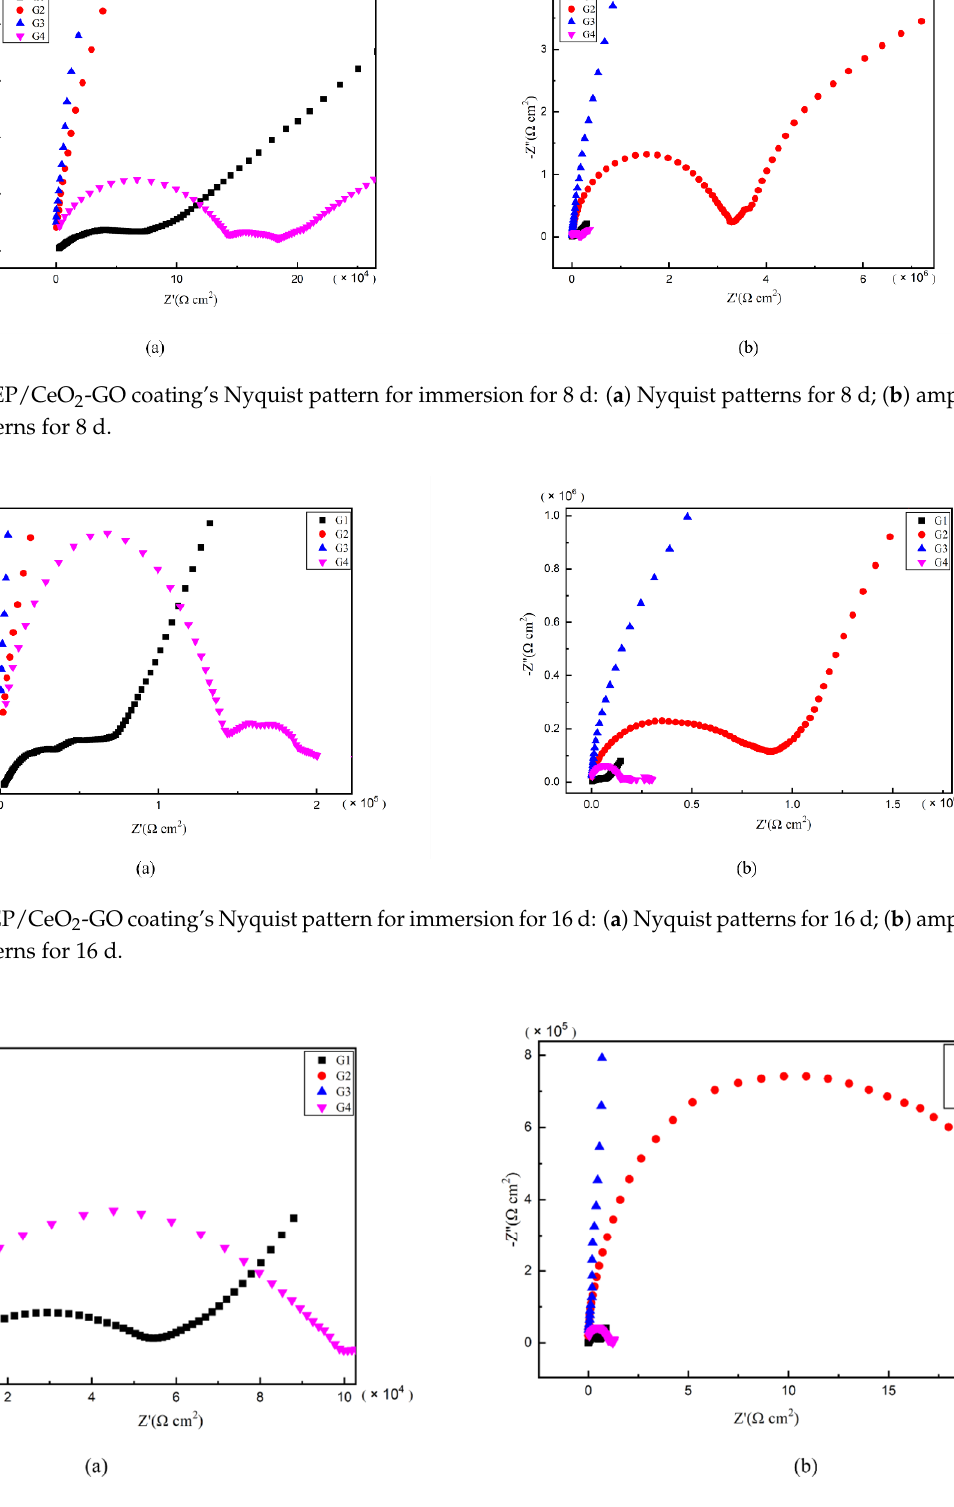
Figure 9. Each EP/CeO 2 -GO coating’s Nyquist pattern for immersion for 24 d: ( a ) Nyquist patterns for 24 d; ( b ) amplification of Nyquist patterns for 24 d.